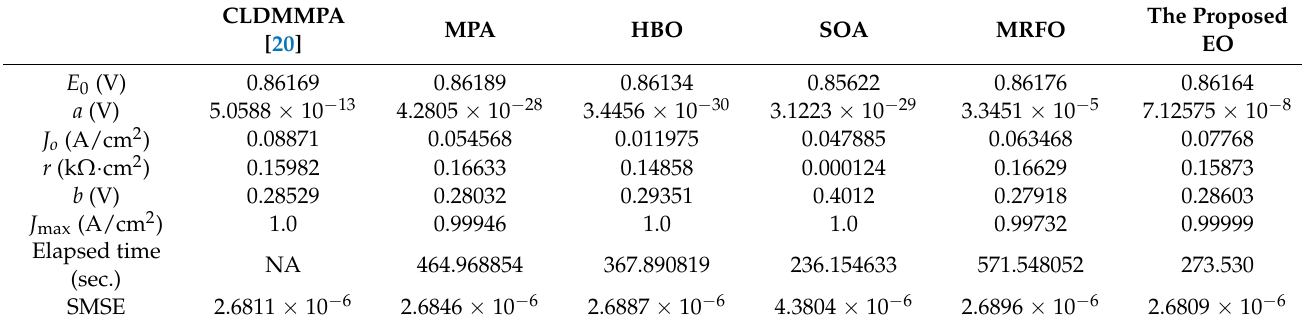
Table 3. The optimal parameters of SOFC steady-state based model operated at 1213